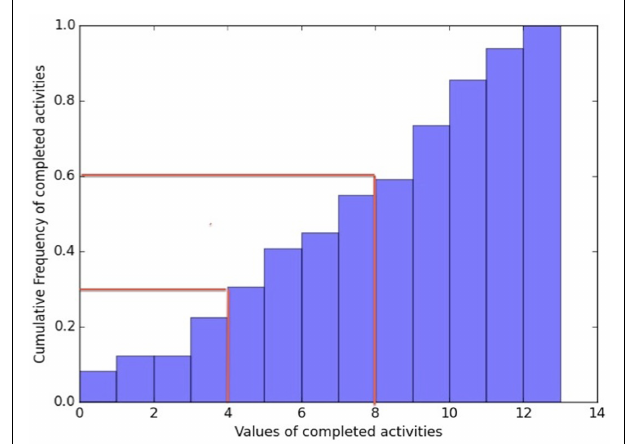
FIGURE 4 | Cumulative frequency curve of completed carried out activities . The red lines indicate the cut-off scores between the autonomy classes which have been based on the analyses of the participant’s performances in terms of completely carried out activities, and on the cumulative frequencies of the completely carried out activities. These were divided in equal parts, as homogeneously as possible in terms of data coverage following the frequency